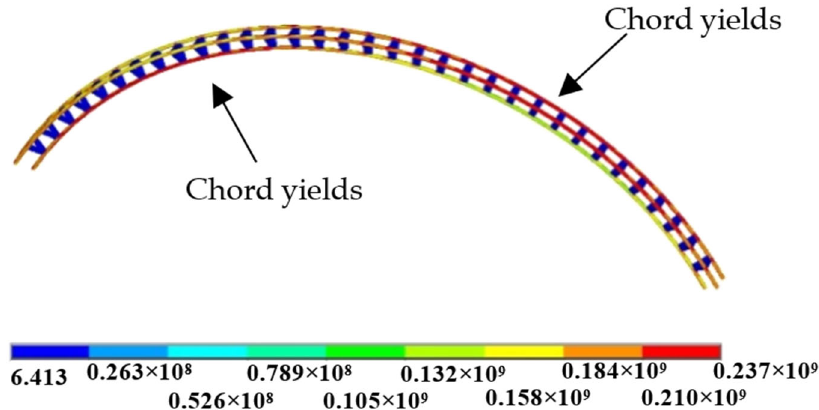
Figure 12. Stress distribution of the arch at point A on the curve (Pa).